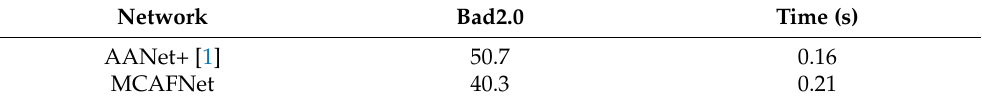
Figure 7. Visual comparison of the pre-training model in the Scene Flow dataset on the Middlebury dataset. The first column is the original image, the second column is the visualization result of AANet+ and the third column is the visualization result of our network. Table 2. The generalization experiment of our network and benchmark model AANet+.